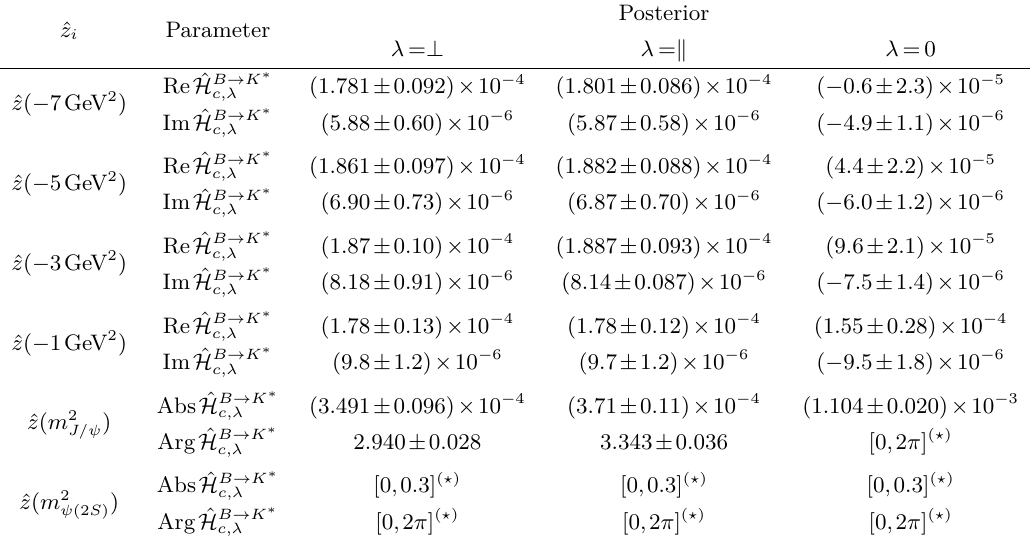
Table 7 . Posteriors of the B → K ∗ non-local FFs fit. The ranges of the parameters that are not constrained in the fit are marked with a star ( ? ) . These large ranges contain more than 99% of the posterior probability. They are suggested by the authors to reproduce the results of this work, as described in the text. The multinormal distribution describing the constrained parameters is given in the ancillary file BToKstar-hatH.yaml